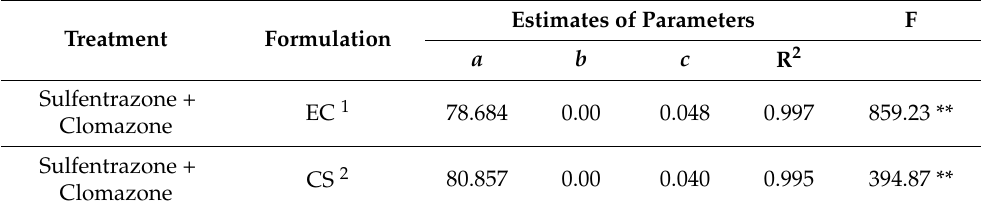
Table 5. Estimates of parameters of Mitscherlich models fitted for the correlation of quantity of sulfentrazone percolated through sugarcane straw with different simulated rainfall depths (mm), after applications combined with emulsifiable concentrate (EC) formulation or microencapsulated (CS) formulation of clomazone.